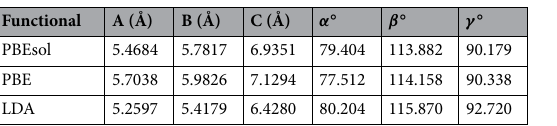
Table 1. Lattice parameters of the N 5 AsF 6 structure in the space group H1 P1 at different levels of theory.